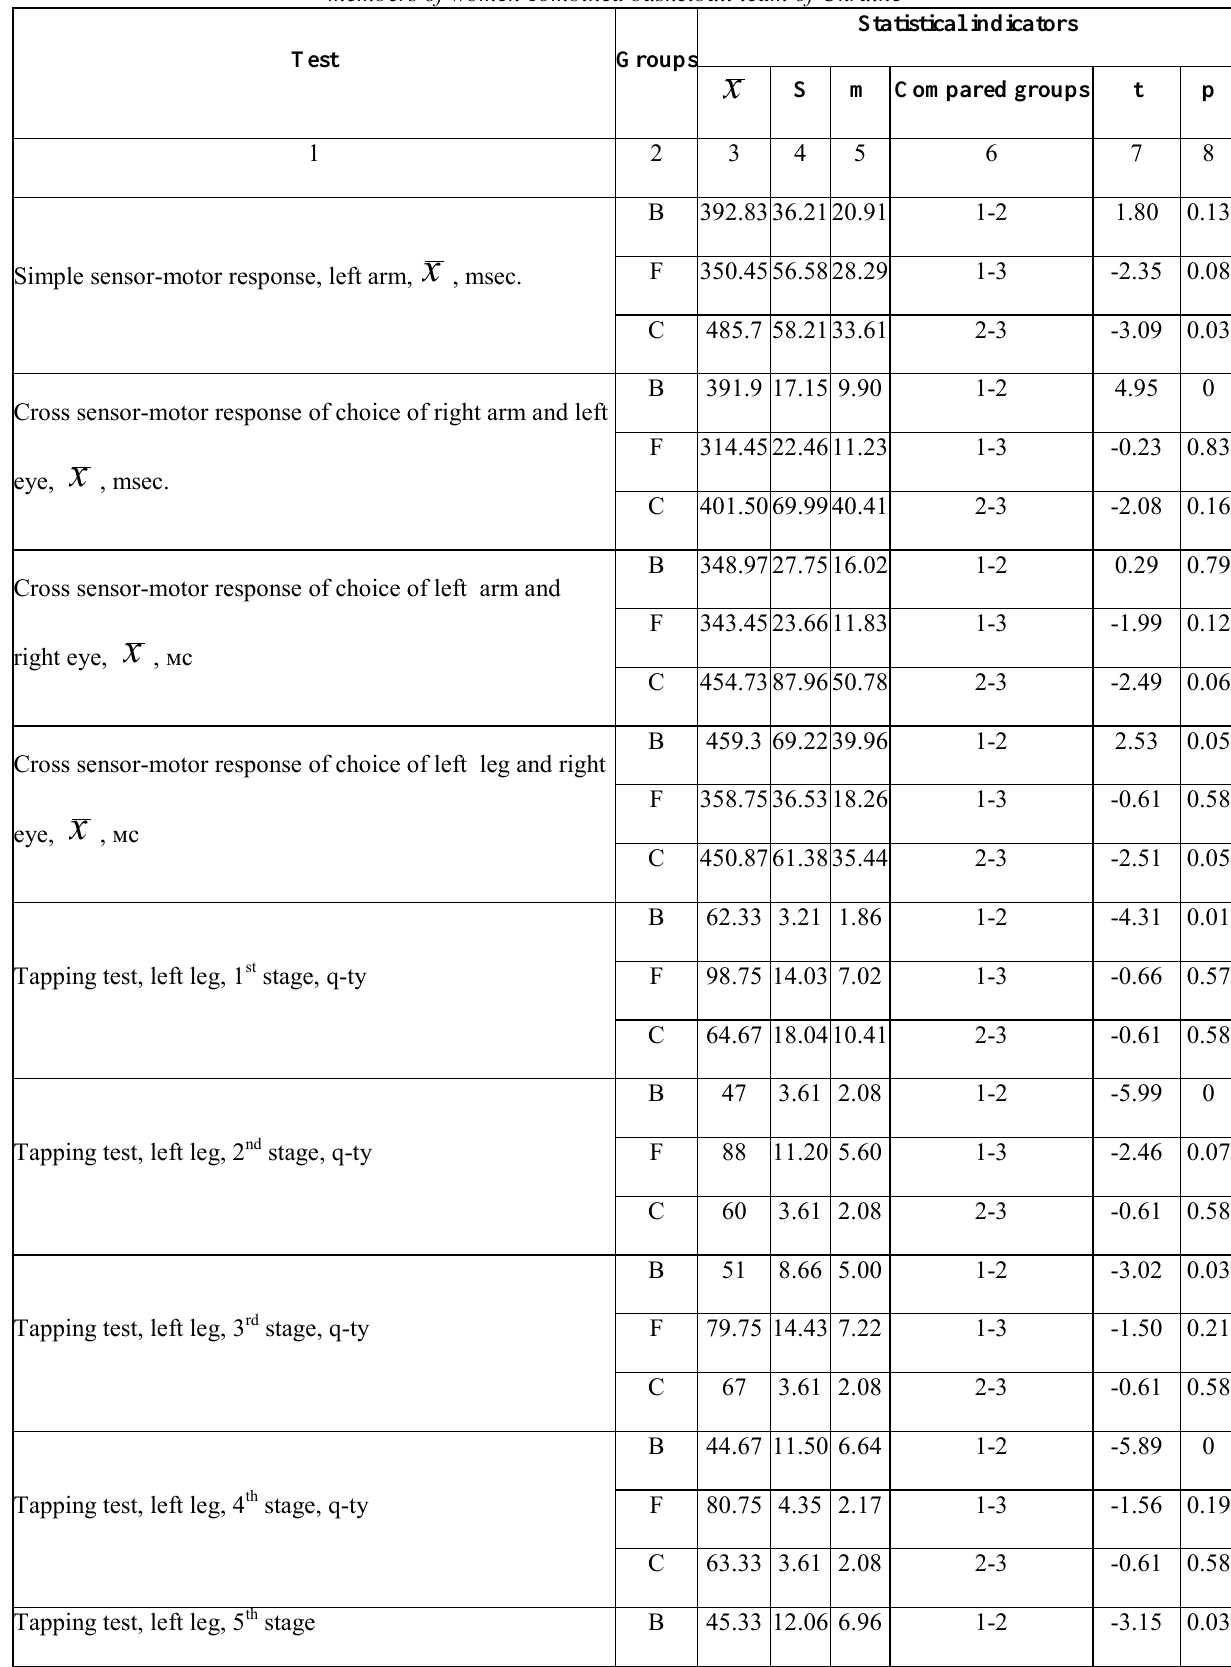
Indicators of psycho-physiological and pedagogic testing of different game functions’ players with hearing problems – members of women combined basketball team of Ukraine Test